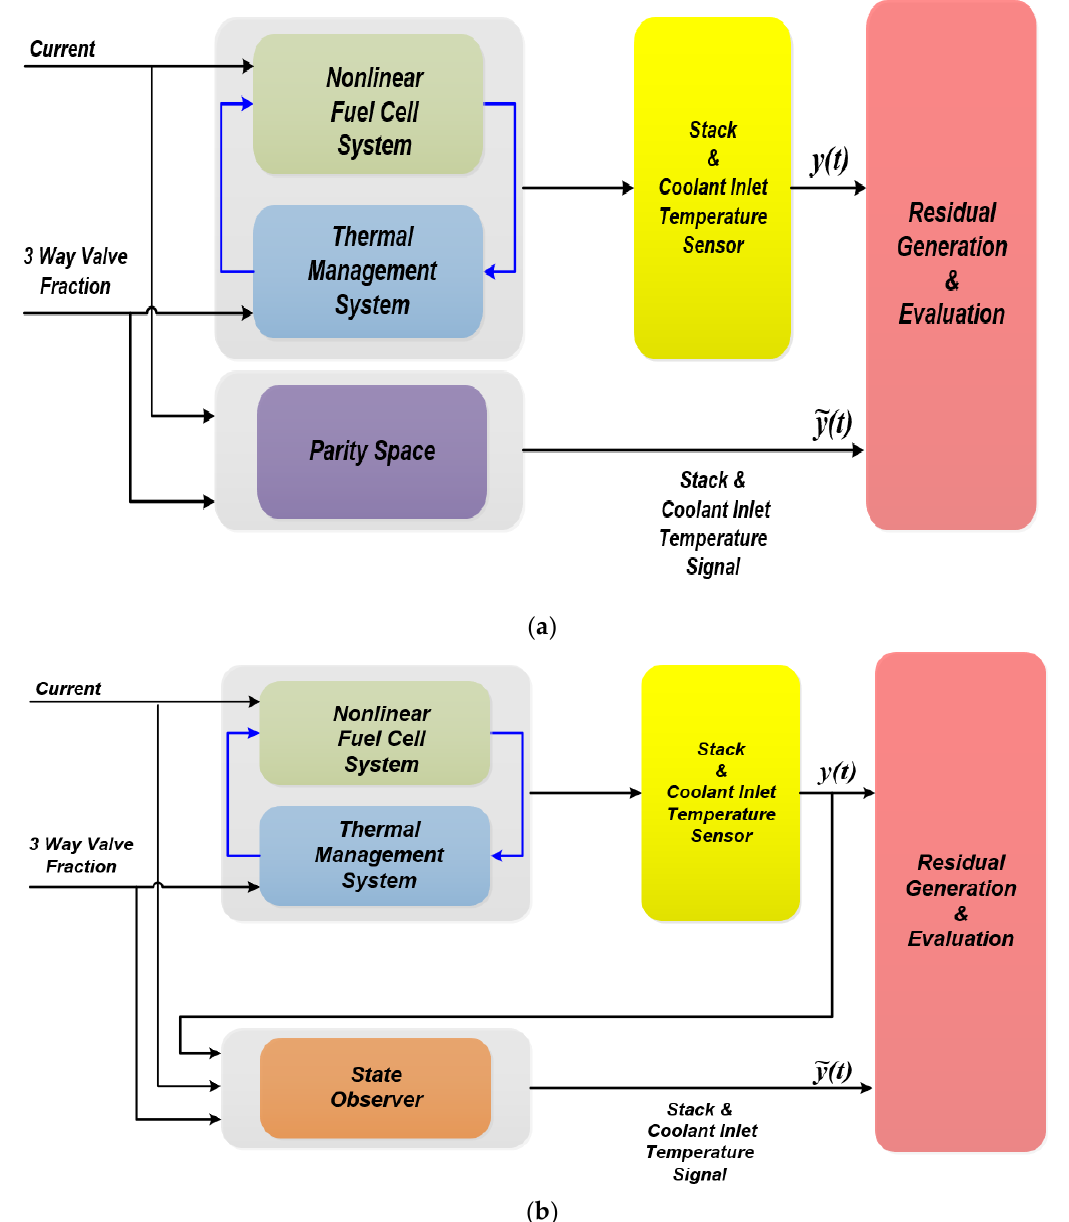
Figure 4. Schematic diagram of proposed model-based fault detection for cooling system sensor (( a ) Parity method, ( b ) State observer and Kaman filter method).